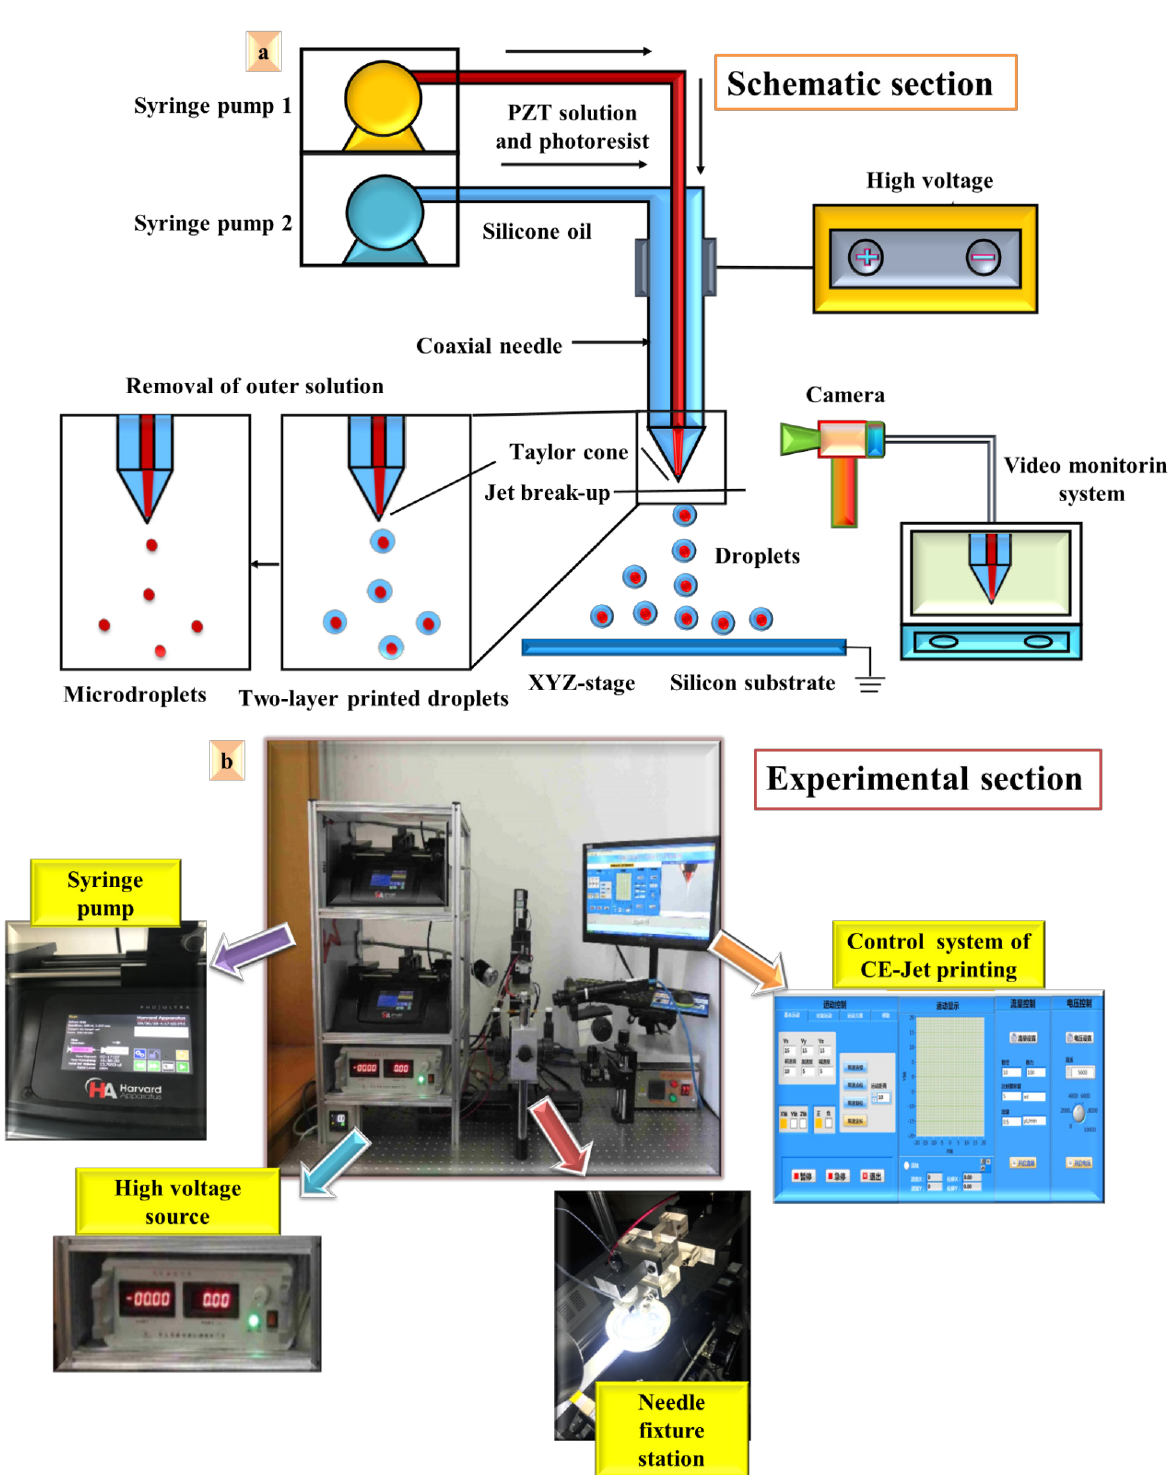
Figure 1. ( a ) Schematic diagram and ( b ) photograph of the DoD CE-Jet printing facilities .